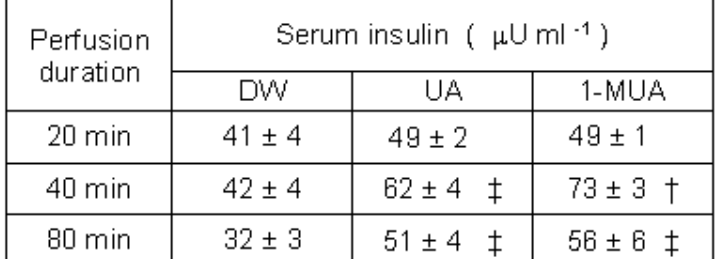
Serum Insulin Levels Following Perfusion of the Urinary Bladder with DW or UA or 1-MUA at 20, 40, and 80